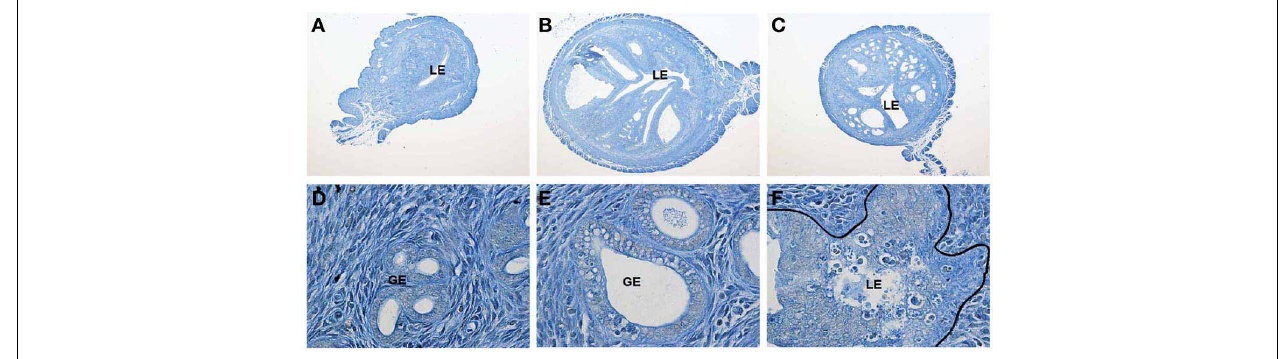
FIGURE 1 | Female Amhr2 cre / + ; Pgrmc1 fl / fl conditional knockout (cKO) mice develop uterine cystic hyperplasia. Shown are uterine cross-sections of control ( Amhr2 + / + ;Pgrmc1 fl / fl , A ) and Pgrmc1 cKO ( Amhr2 cre / + ;Pgrmc1 fl / fl ; B and C ) female mice at 6 months of age (40X). Extensive cystic hyperplasia is evident in glandular tissue in sections from cKO mice. Higher magnification images (600X) reveal